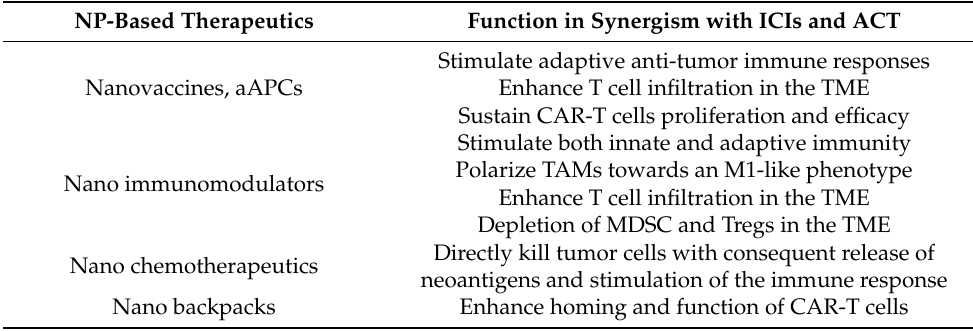
Table 2. Main functions of nanotherapeutics in synergy with